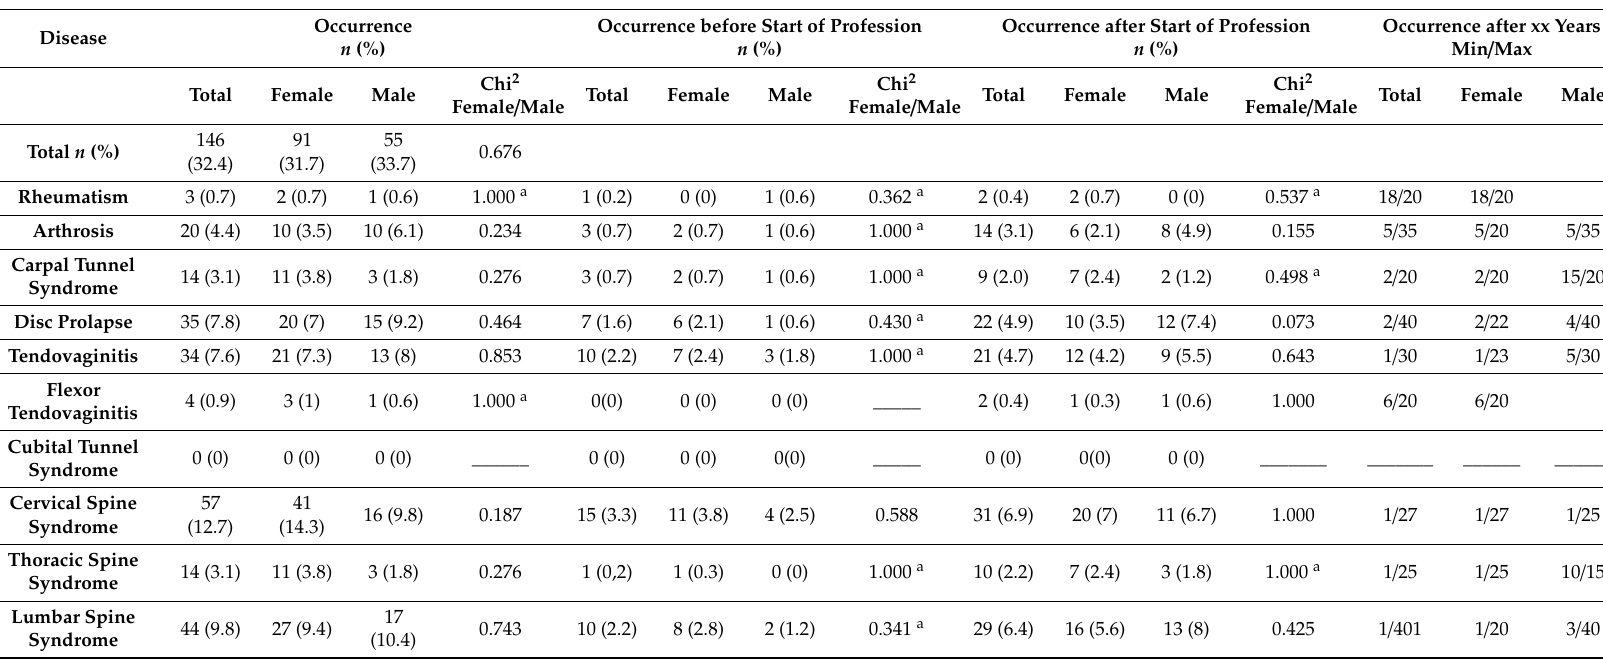
Table 5. General diseases in terms of their occurrence for all respondents, separated by gender. An asterisk after the chi 2 value symbolizes the significance level (* p < 0.05, ** p < 0.01, *** p < 0.001). An ‘ a ’ stands behind the chi 2 test, if Fisher’s exact test was applied when 20% of the cells of a contingency table were below 5.